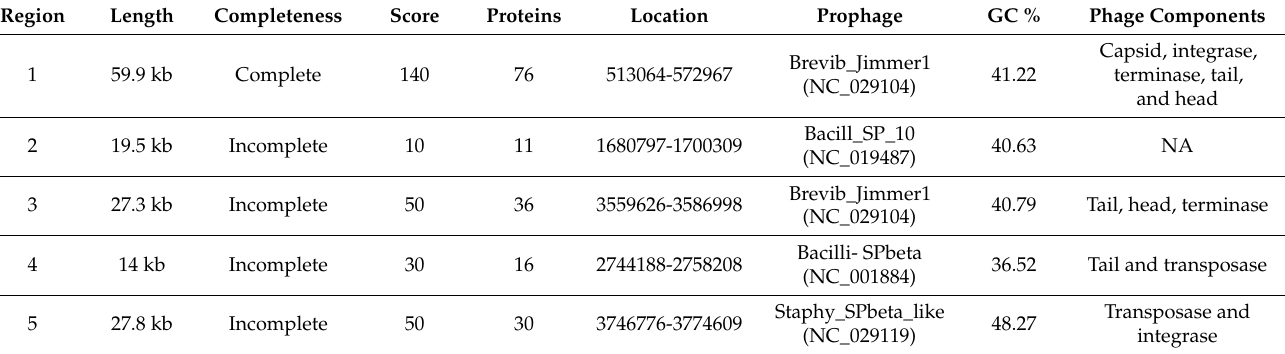
Table 1. Characterization of prophages in B.pumilus strain SF-4